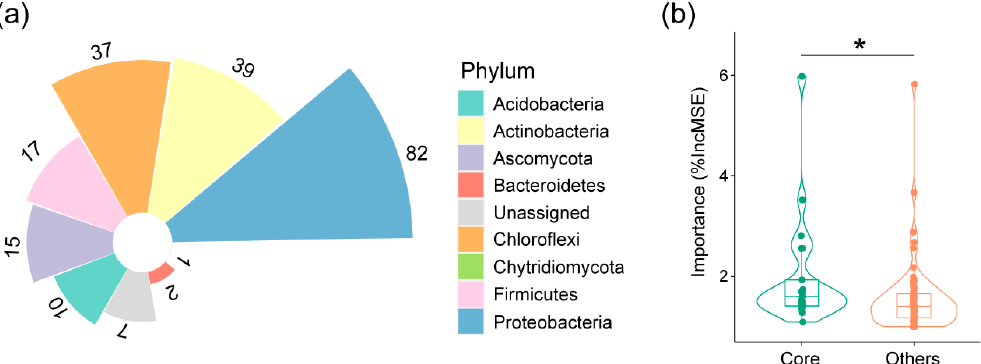
Figure 3. Correlation between core microbiota and nodulation ability of peanut. ( a ) Circular bar chart shows the compositions of core microbiota at the phylum level. ( b ) Mean contribution (% of increased mean square error) of microbial taxa to peanut nodulation ability based on random forest modeling. The magnitude of the MSE% value implies the importance of the predictors (* p < 0.05). A co-occurring network of core rhizosphere taxa was constructed using WGCNA.